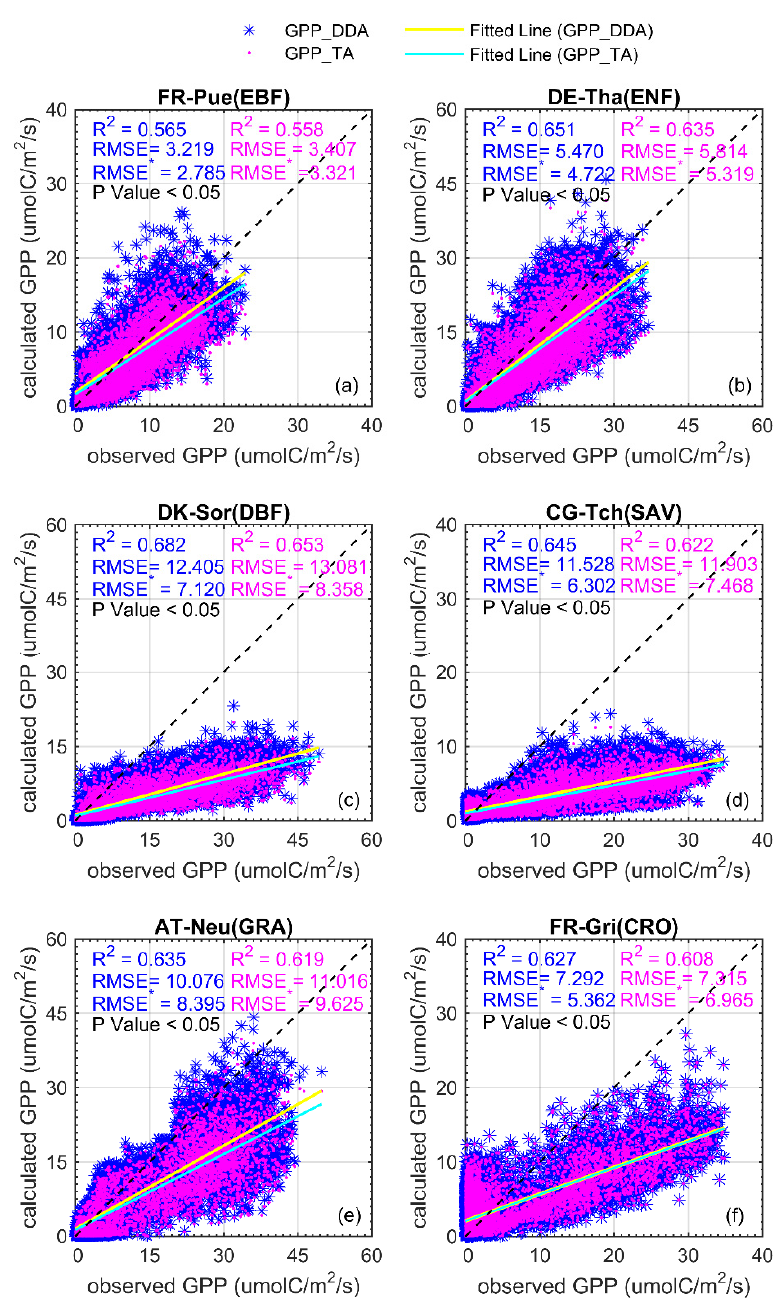
Figure 4. Comparison of the calculated GPP and observed GPP for different vegetation types: ( a ) EBF; ( b ) ENF; ( c ) DBF; ( d ) SAV; ( e ) GRA, and ( f ) CRO (the label of “GPP_DDA” and “GPP_TA” denote the half-hourly GPP calculated using the DDA method and total APAR-based method; observed GPP are the half-hourly GPP derived from FLUXNET2015).